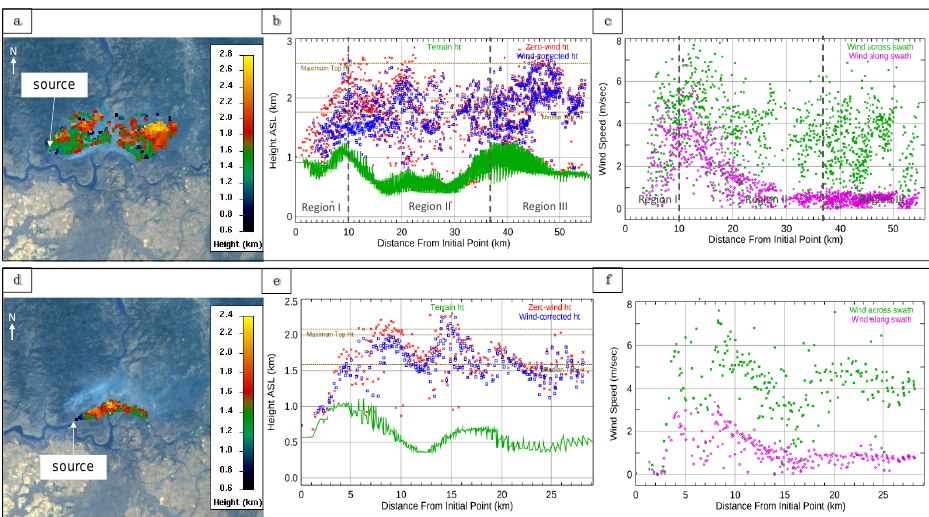
Figure 2. Height and wind properties for the Williams Flats Fire retrieved by MISR at 19:06 UTC (Orbit 104434, Path 45, Block 52) on 06 August 2019. The top panels ( a – c ) correspond to retrievals for the northern plume, whereas the bottom panels ( d – f ) correspond to the southern plume. Panels ( a , d ) are MISR-MINX stereo height retrieval map; ( b , e ) are MINX stereo height profiles as a function of distance from the source, for both zero-wind (red) and wind-corrected (blue) analyses, with surface elevation indicated in green; and ( c , f ) are the across-swath and along-swath wind vectors. The dashed grey lines in panels ( b ) and ( c ) represent the dividing lines between regions in the northern plume defined in Figure 1.